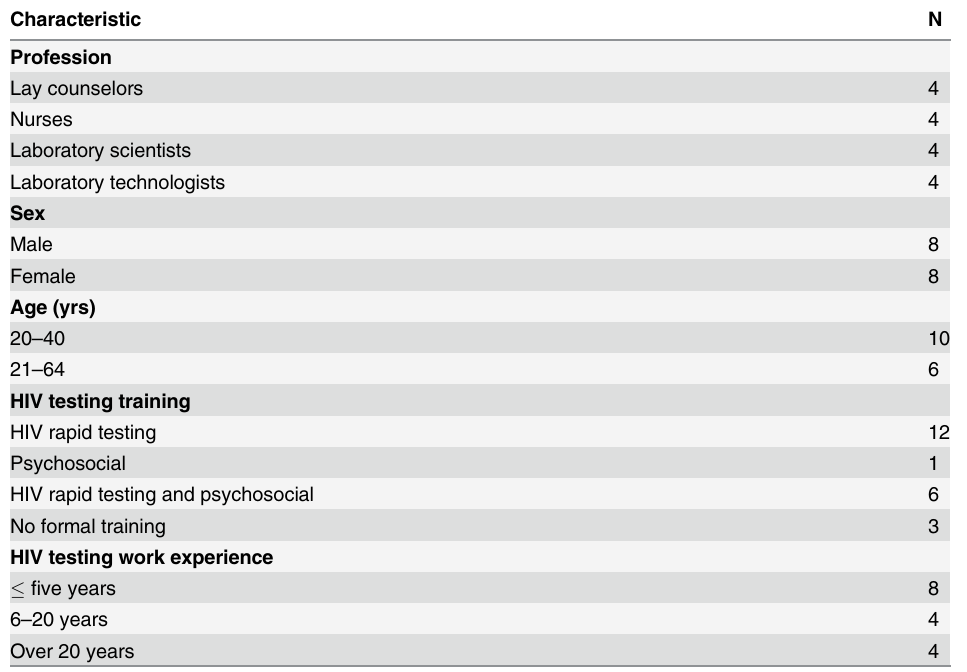
Table 1. Demographic characteristics of the